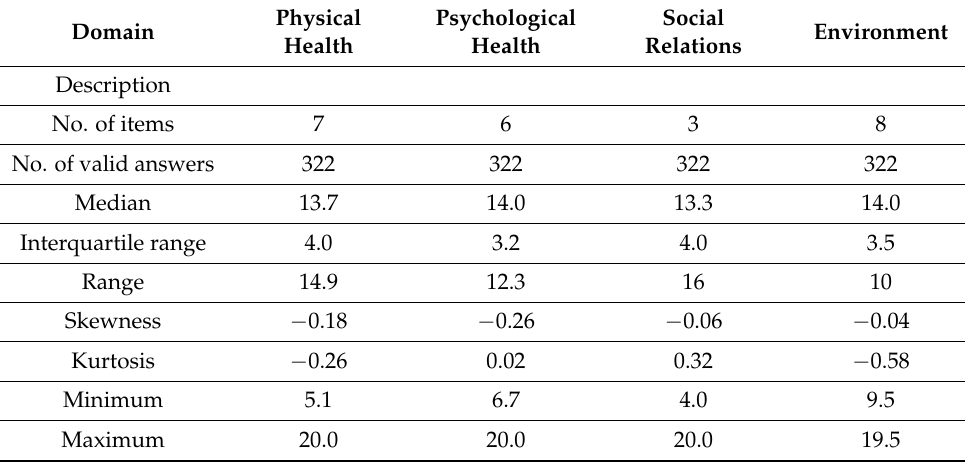
Table 3. Frequency analysis of scores obtained for the four domains of the